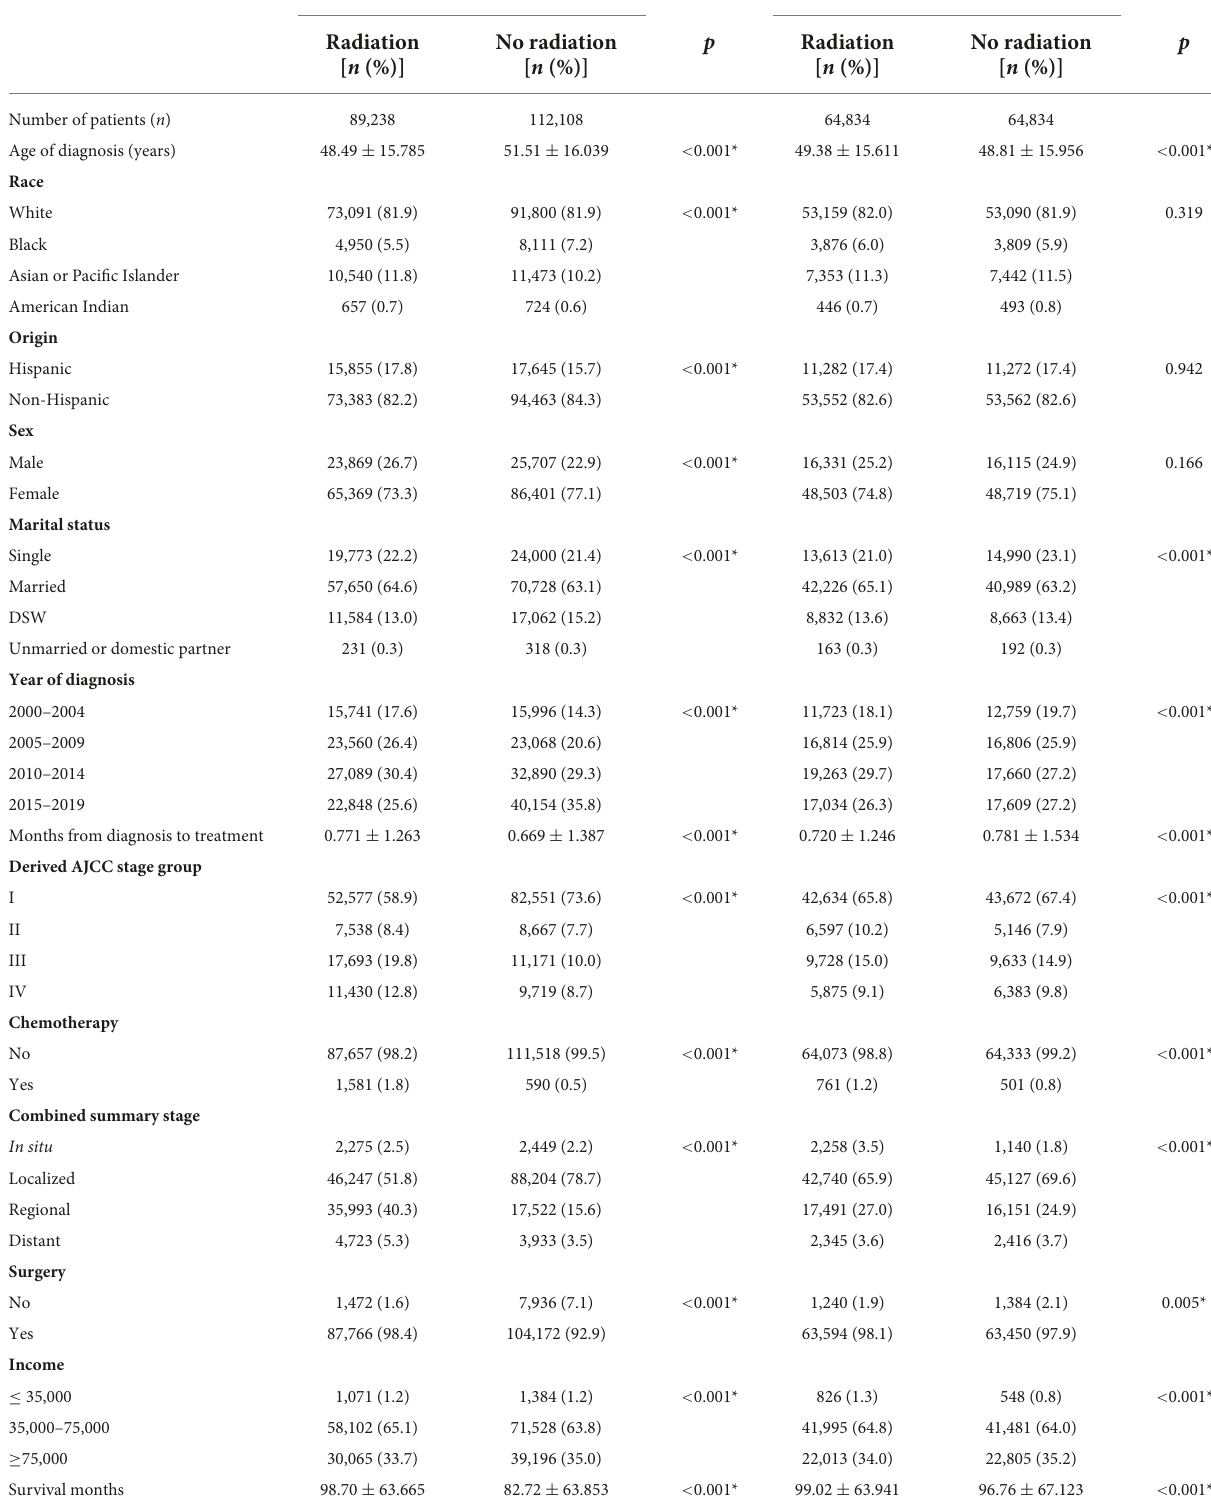
TABLE 1 Characteristics of patients included in non-malignant tumor patients.